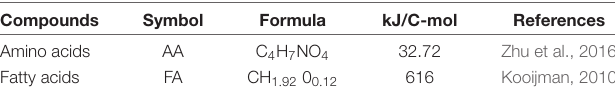
total energy maintenance cost from 0.018 to 0.059 kJ day − 1 .